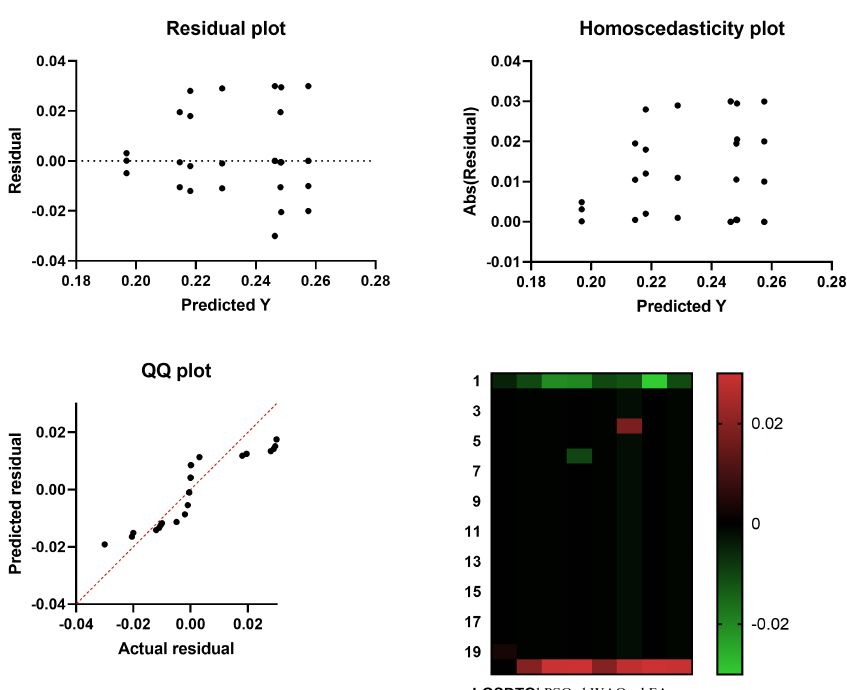
Figure 6. Residual, QQ, homoscedasticity plots, and heat map of the bGSDTO and compared